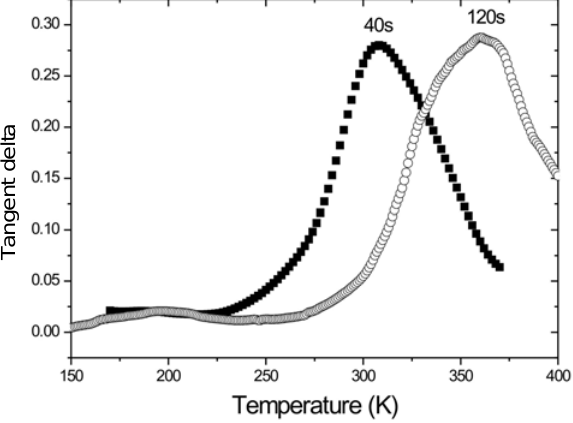
FIGURE 2- Tangent delta for Fill Magic composite for 40- and 120-s exposure